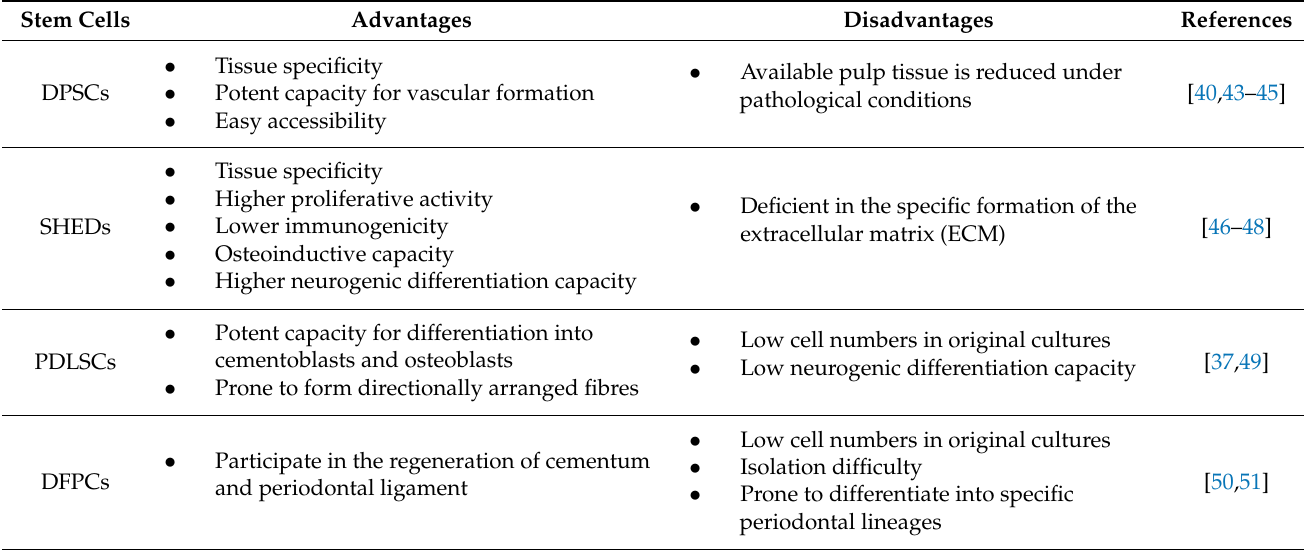
Table 4. Characteristics of stem cells and their application in pulp